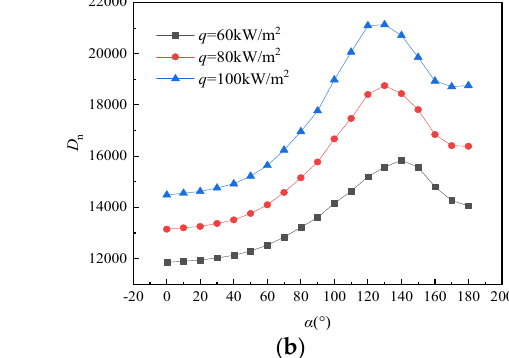
Figure 10. The changes in h with L / D and in Dn with α under different heat flux conditions: ( a ) L/D , ( b ) α (°).